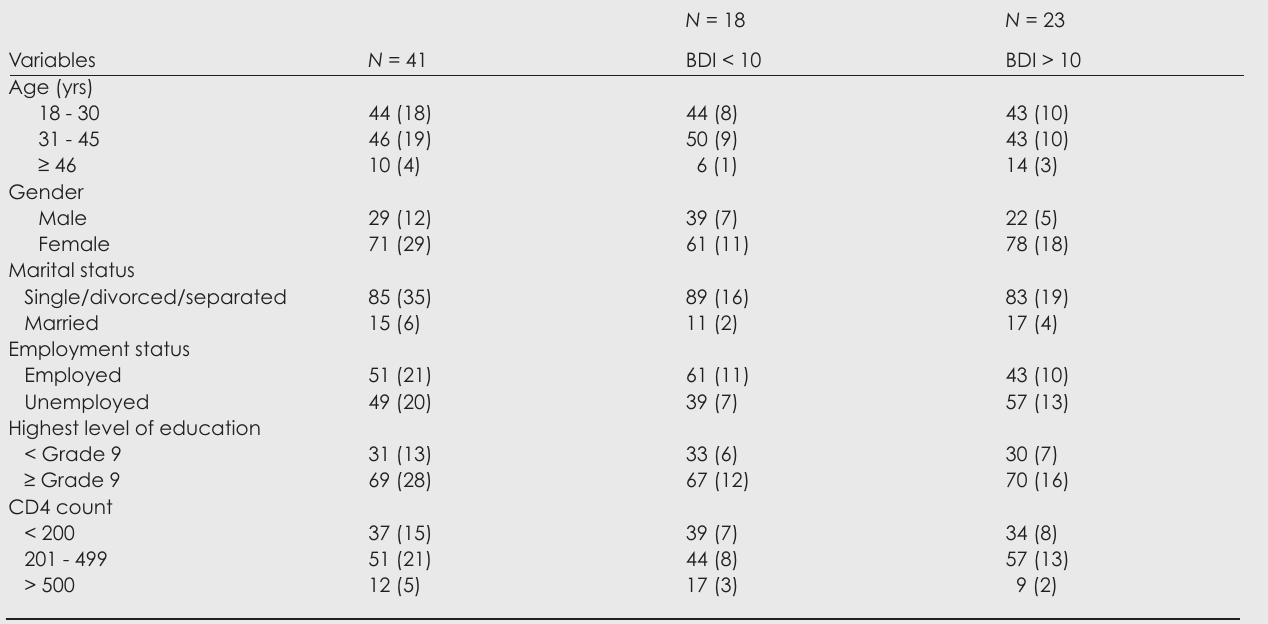
Table I. Demographic data of the study sample (% ( N ))